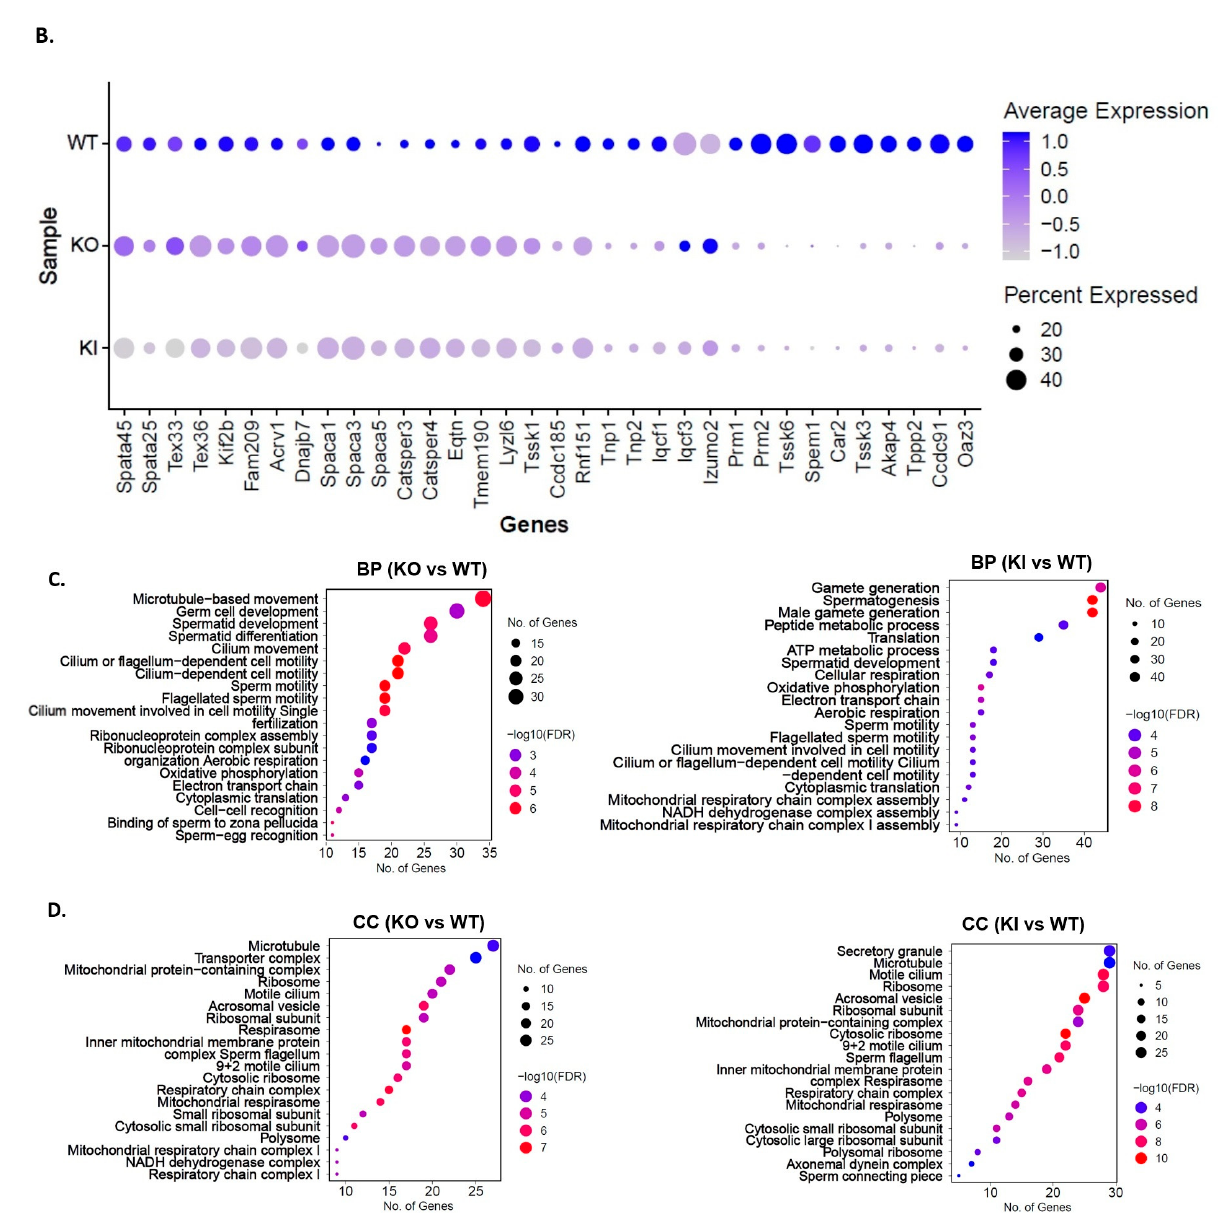
Figure 4. Altered transcriptional profiles in RS clusters of KO and KI during spermiogenesis. ( A ) Dot plot analysis of specific marker genes that are expressed in different stages of RS differentiation transitioning to ESs (condensed spermatids). ( B ) Dot plot showing differential expression of selected marker genes in RS of WT, KO and KI during spermiogenesis. ( C ) GO enrichment analysis on DEGs from RS cluster. Biological process significantly enriched in GO analysis of DEGs from KI to WT and KO to WT groups. ( D ) Cellular components significantly altered in GO analysis of DEGs from KI to WT and KO to WT groups.